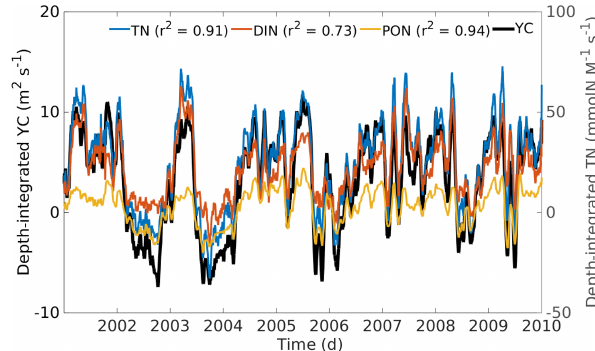
Figure 14. Temporal series for the 9 simulated years of cross-shelf Yucatán Current component (YC), total nitrogen (TN), dissolved inorganic nitrogen (DIN), and particulate organic nitrogen (PON), vertically integrated and averaged over the isobath 250m of the eastern boundary. The square of the correlation coefficients ( r 2 ), between YC and the biogeochemical variables, is shown at the top. The temporal series are filtered by a moving average of 30d to re- move daily